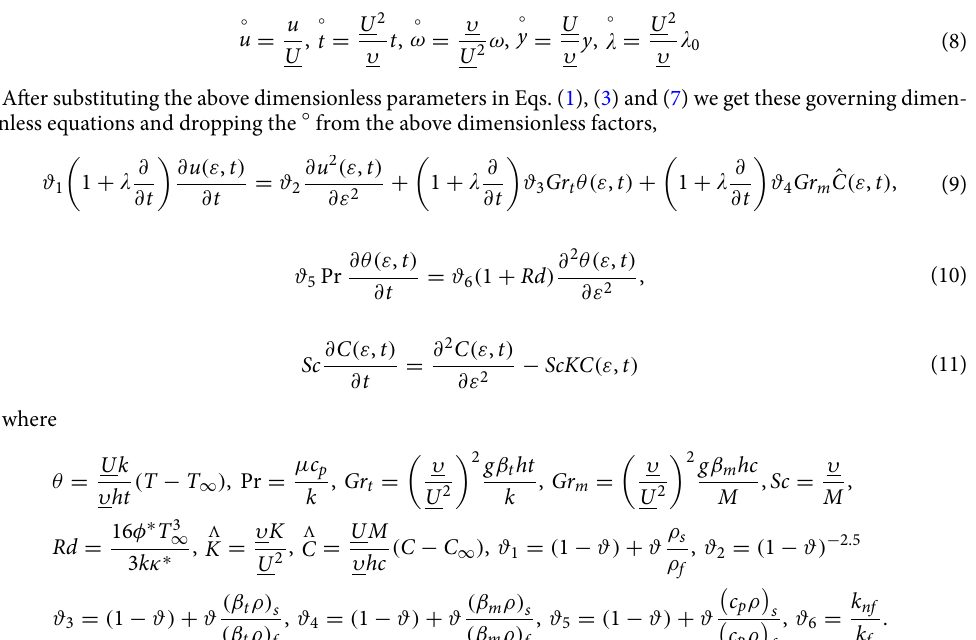
The dimensionless parameters are given below;